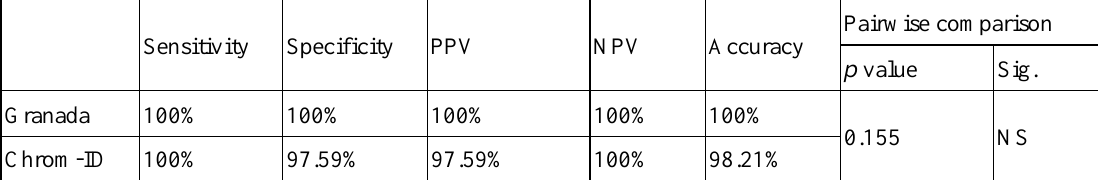
Table 2. Sensitivity, specificity and accuracy of Granada and Chrom ID StreptoB agar to detect GBS.